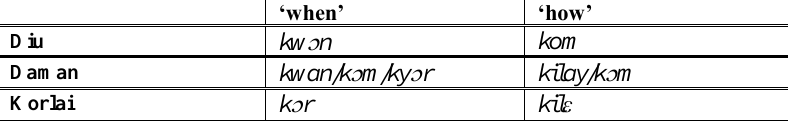
Table IX. Question words with form variation in Diu, Daman, and Korlai ‘when’ ‘how’ Diu